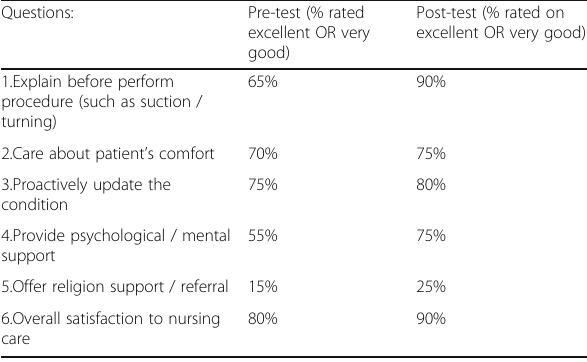
Table 1 (abstract 001731). Results of pre-intervention and post- intervention